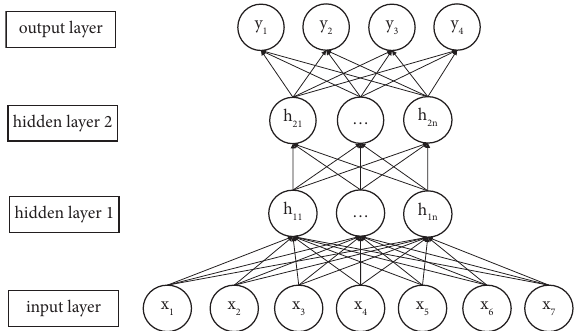
Figure 1: Prediction model of passenger fow of subway stations based on multilayer perceptron.